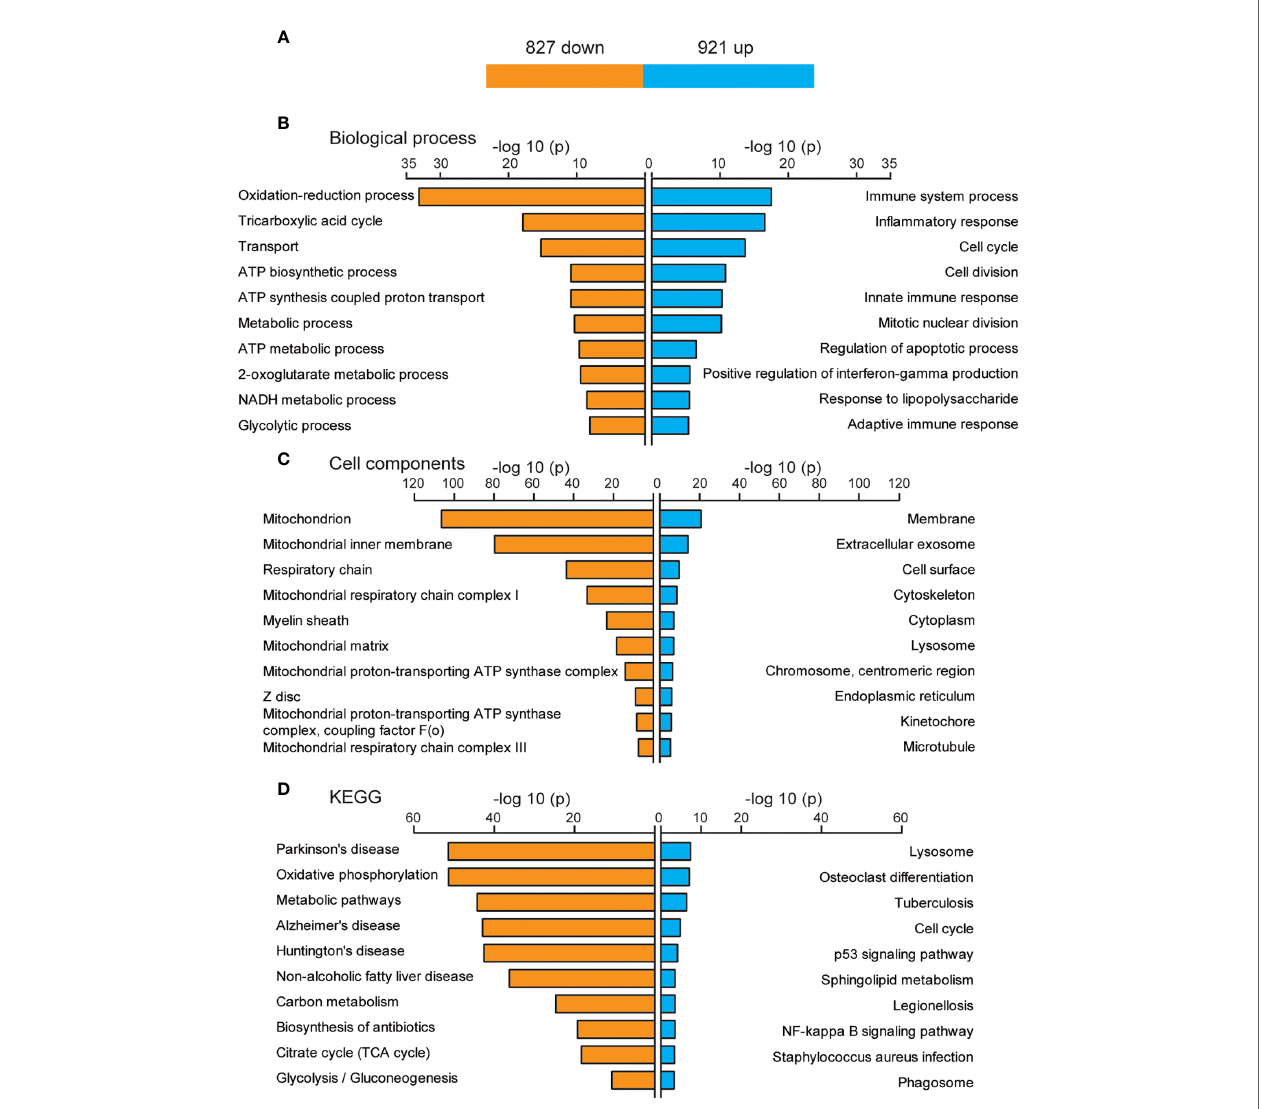
FIGURE 4 | Biological functions of newly discovered differentially expressed genes (DEGs) after three days of interleukin-6 (IL-6) infusion. (A) The number of DEGs that were newly discovered after three days of IL-6 infusion. Blue indicates up-regulated genes, and orange indicates down-regulated genes. (B) The GO analysis results of up-regulated and down-regulated DEGs according to the biological process. (C) The GO analysis results of the up-regulated and down-regulated DEGs according to the cell component. (D) Kyoto Encyclopedia of Genes and Genomes (KEGG) pathway analysis of the up-regulated and down-regulated DEGs. The top 10 GO or KEGG terms are displayed. ATP, adenosine triphosphate; up,